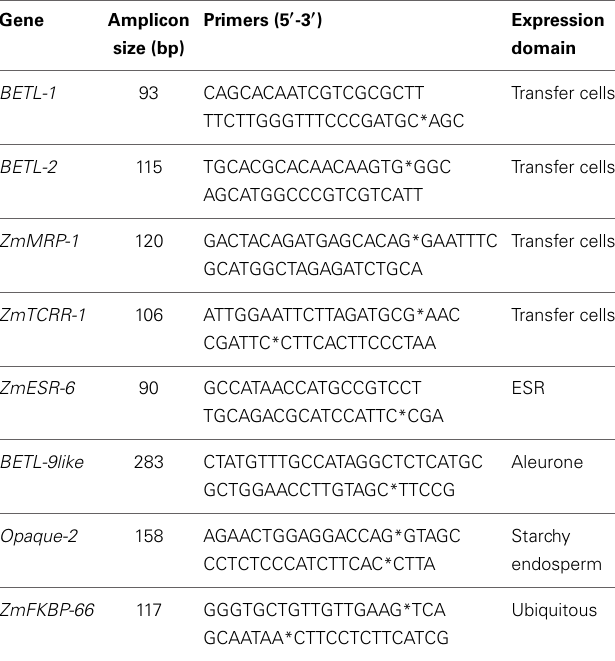
Table 1 | Summary of primers used in the transcriptomic analysis. Gene